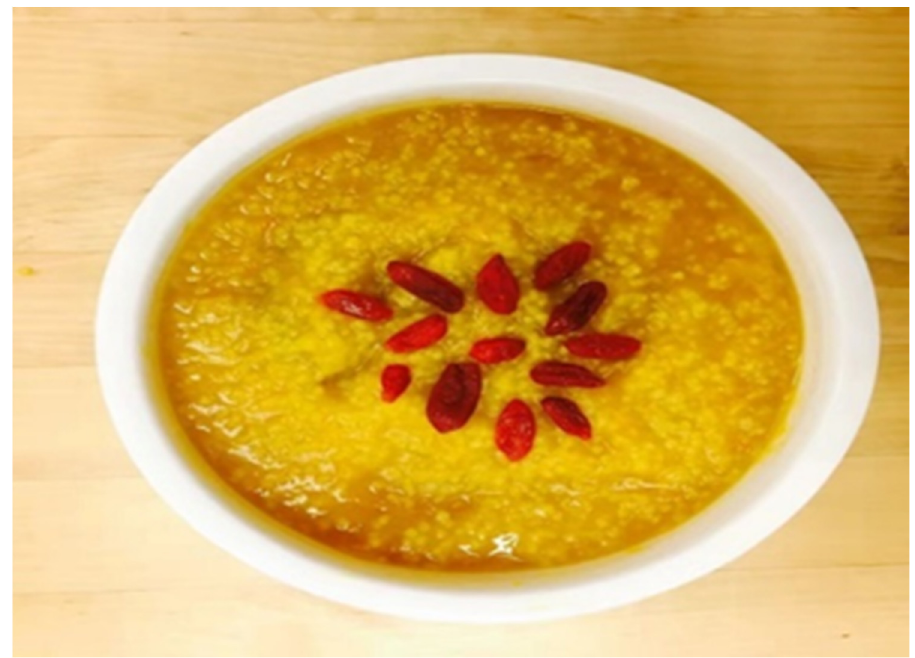
Figure 13. Photograph by Participant B .